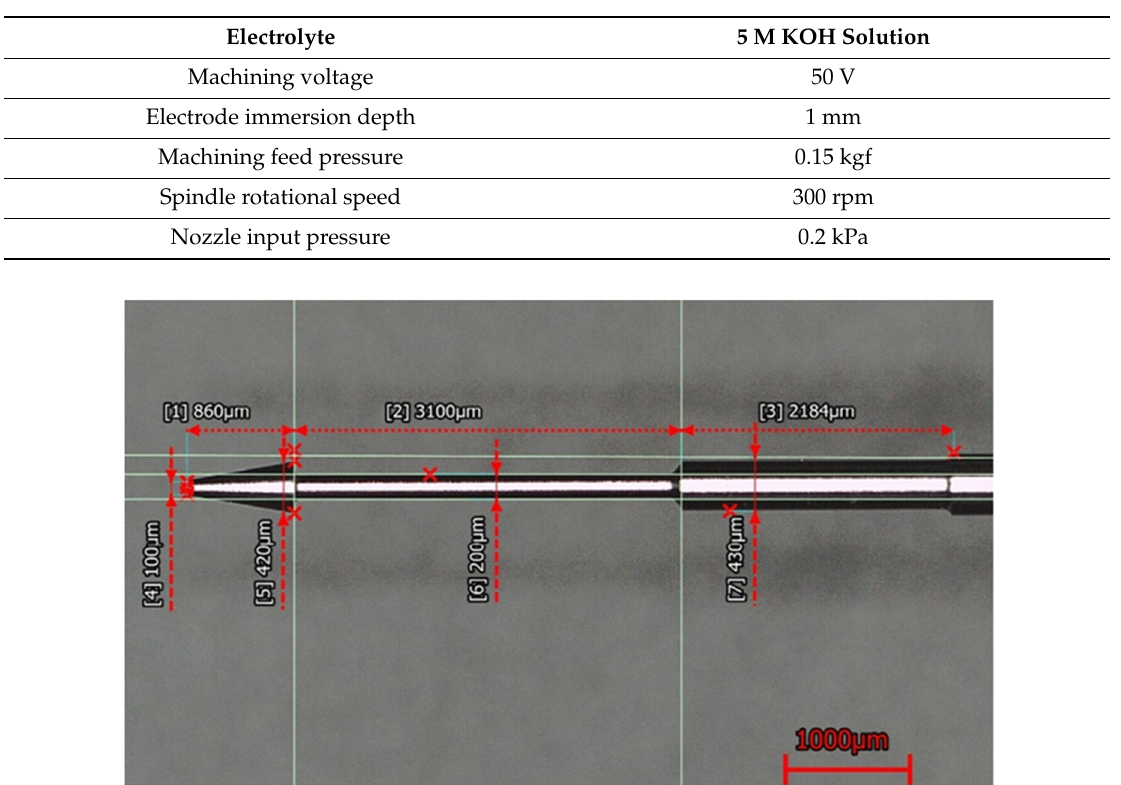
Figure 2. Machining electrode used in the experiments of this research.